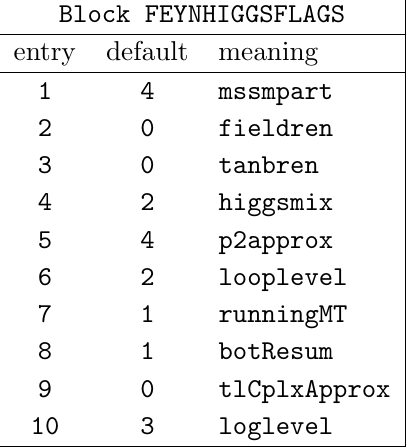
Table 16 . Input parameters of Block FEYNHIGGSFLAGS as they are compatible with FeynHiggs 2.13.0 and 2.14.0 . For the meaning and ranges (dependent on the FeynHiggs version) of the settings we refer to the FeynHiggs webpage [77]. If they are not speci(cid:12)ed they are automatically set to the default values of FeynHiggs 2.13.0 . The settings fieldren and tanbren were removed in FeynHiggs 2.14.0